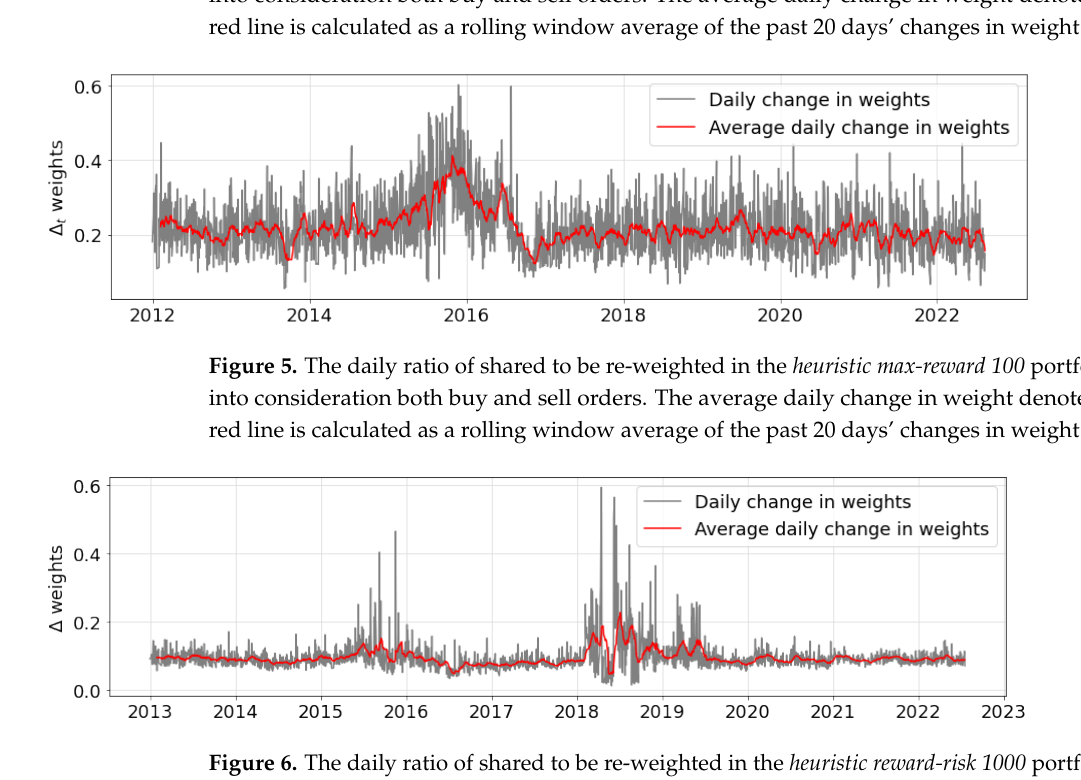
Figure 6. The daily ratio of shared to be re-weighted in the heuristic reward-risk 1000 portfolio, taking into consideration both buy and sell orders. The average daily change in weight denoted with the red line is calculated as a rolling window average of the past 20 days’ changes in weight.